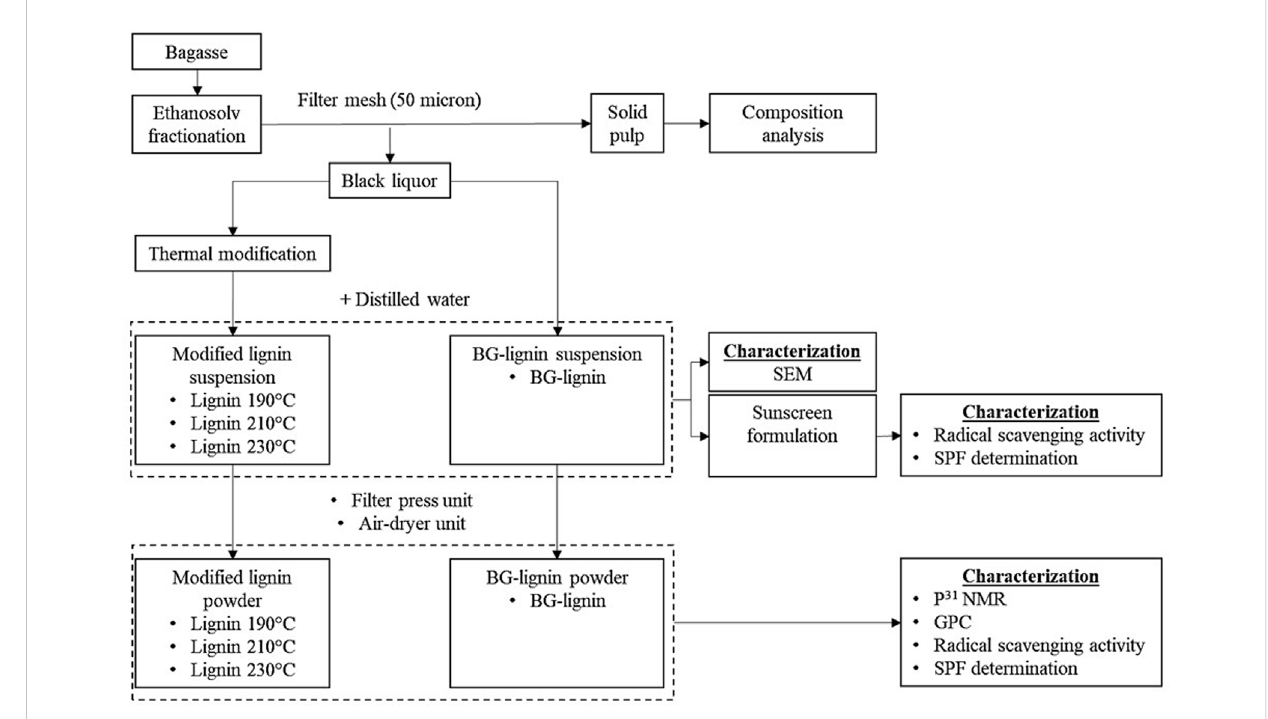
FIGURE 1 Organosolv fractionation and modi fi cation scheme os ligin for functional additive